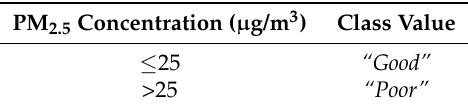
Table 1. Class values guided by WHO recommended exposure limits for indoor PM 2.5